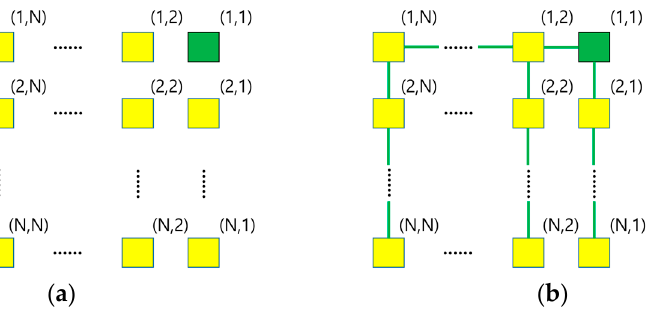
Figure 10. Region of a sensor network and its routing tree. ( a ) A region that consists of N × N nodes. ( b ) Comb-type routing tree with the root node at (1,1).